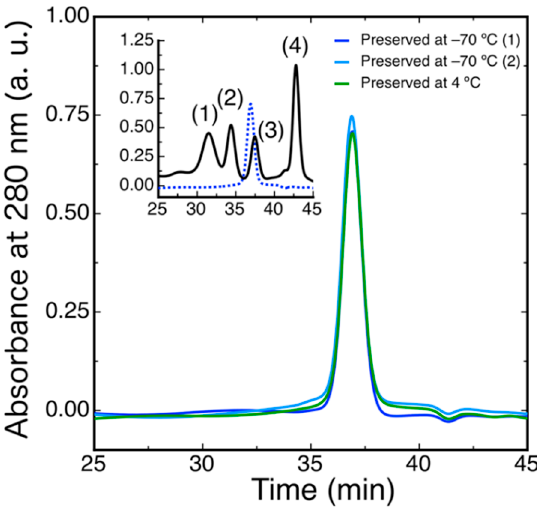
Figure 4. Hydrodynamic Characterization of DdFXN by means of SEC-HPLC. DdFXN (40 µ M, 50 µ L) was loaded in a Superose 6 column equilibrated in buffer 20 mM Tris-HCl, 100 mM NaCl, 1 mM EDTA, pH 7.0. Sample maintained during 30 days at 4 ° C (green line) and samples preserved at − 70 ° C (blue and cyan lines). The inset shows the chromatogram corresponding to the molecular mass markers (black line): (1) gammaglobulin (158 kDa), (2) ovoalbumin (44 kDa), (3) myoglobin (17 kDa), and (4) vitamin B12 (1350 Da) and a chromatogram corresponding to DdFXN, for reference (blue dashed line).